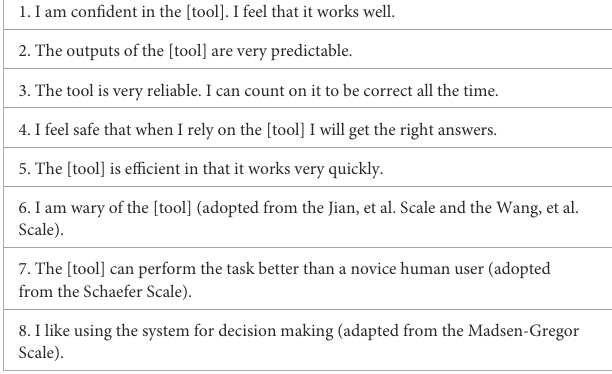
TABLE 8 The trust scale for the XAI